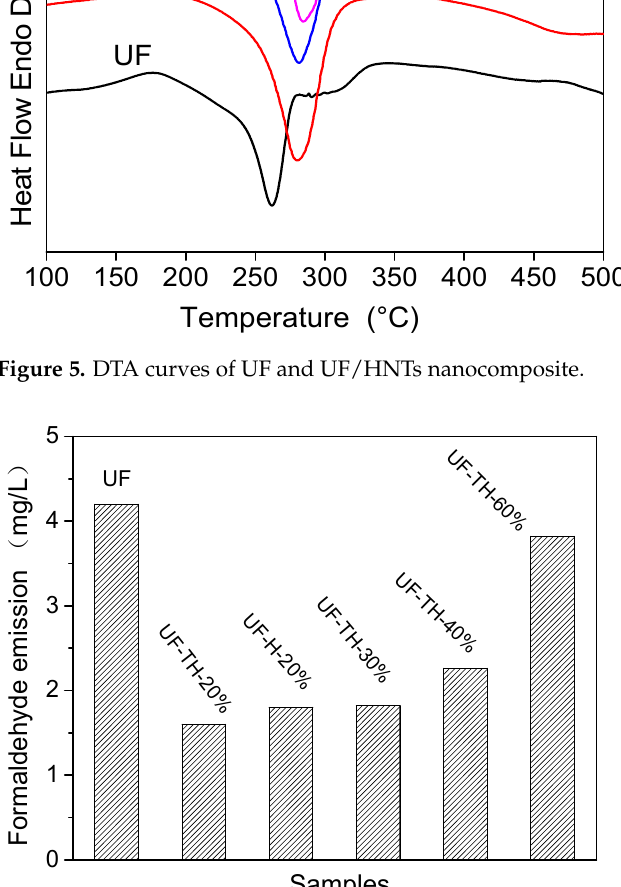
Figure 6. Formaldehyde emission of plywood samples with the addition of UF nanocomposites. These results are in agreement with other research, where HNTs could be used as adsorbent for small molecules